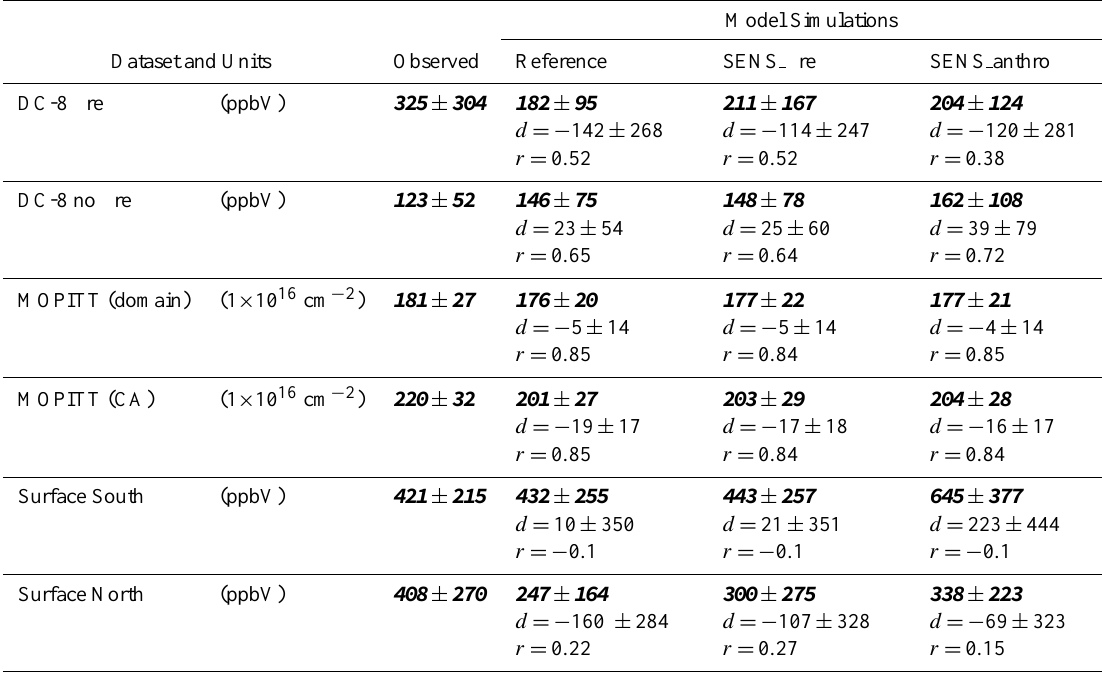
Table 1. Evaluation statistics for the three different WRF-Chem simulations. Listed are mean observed and modeled mixing ratios (italic bold), mean bias ( d ) and correlation coefficient ( r ).